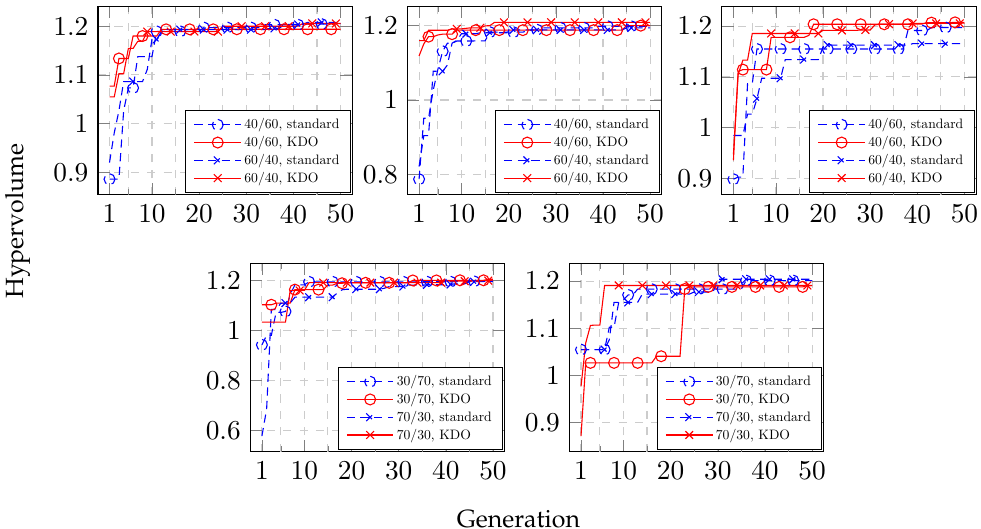
Figure 8. Convergence plots of the scenarios with 7 operators ( top left ), 8 operators ( top center ), 9 operators ( top right ), 6 operators ( lower left ), and 10 operators ( lower right